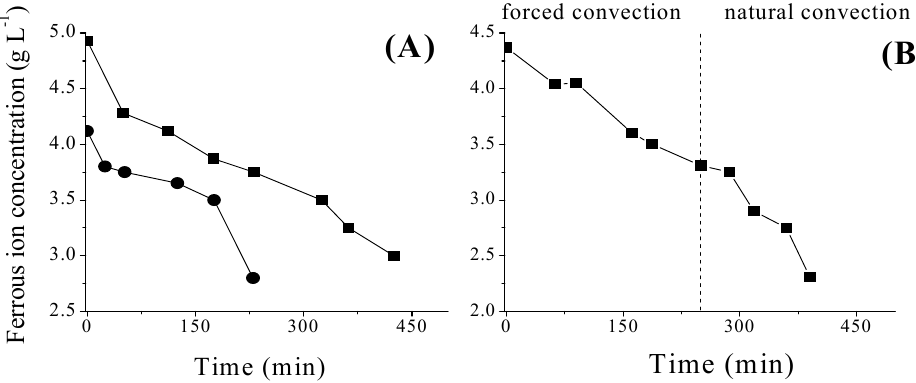
Figure 2. Biological oxidation of Fe(II) to Fe(III) in ( A ) the forced convection mode (black squares: assay 1, black circles: assay 2) and ( B ) the forced / natural convection mode (black squares: mixed assay).